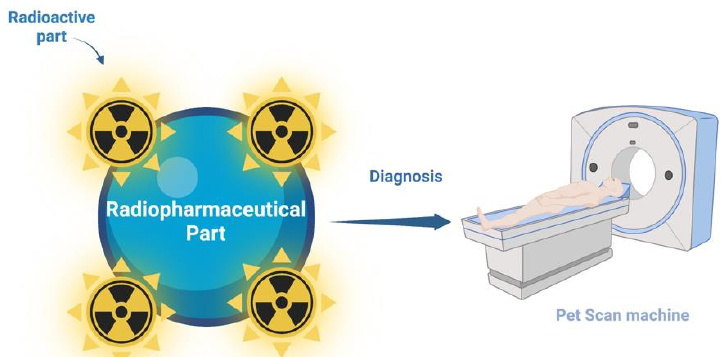
Figure 8. The scheme of radiopharmaceuticals. Radiopharmaceuticals contain radioactive and pharmaceutical parts. They can be applied for diagnosis purposes, especially PET-scan techniques as well as others (created with BioRender.com).